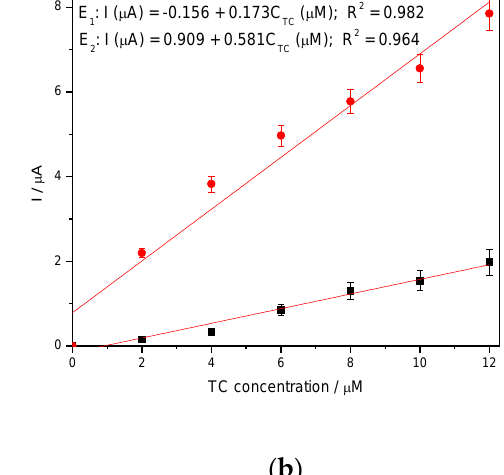
Figure 11. ( a ) SWV recorded on a Ag/GO/BDD in 0.1 M Na 2 SO 4 supporting electrolyte under optimised conditions at a frequency of 10 Hz, step potential (SP) 10 mV and modulation amplitude (MA) 100 mV in the potential range of − 0.500 to +1.00 V vs. SCE in the presence of a 2-12 µM TC concentration; ( b ) The calibration plots of the currents recorded at recorded at E 1 = +0.436 V/SCE and E 2 = +0.670 V/SCE versus TC concentrations. Table 4. The analytical parameters obtained using square wave voltammetry at frequency of 10 Hz. Operating Conditions Electroanalytical Performance Supporting